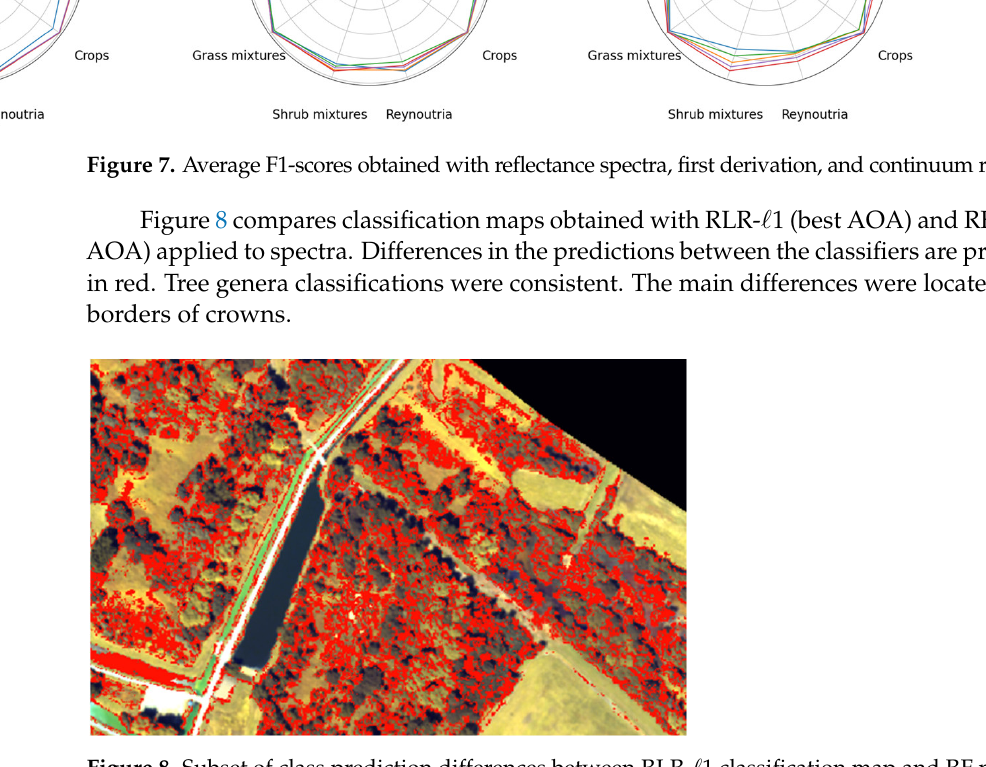
Figure 8. Subset of class prediction differences between RLR-ℓ1 classification map and RF map.